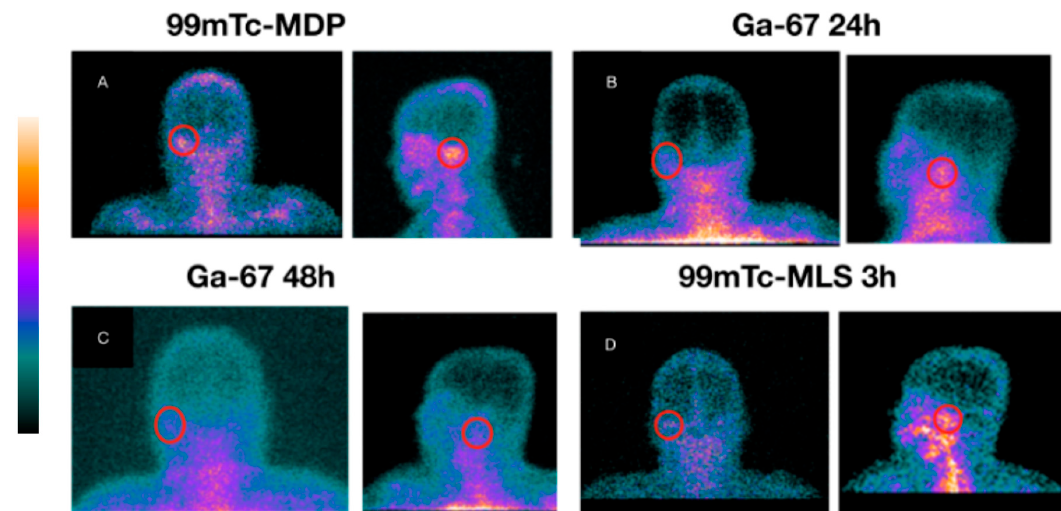
Figure 3. Patient 11. ( A ) Bone 99m Tc-MDP scintigraphy in left mastoid topography (posterior and lateral incidence). ( B ) 67 Ga scintigraphy taken 24 h after radiotracer iv. injection showing higher uptake at the region of interest (ROI, red ring). ( C ) 67 Ga scintigraphy taken 48 h after radiotracer iv. injection showing a long-lasting higher uptake at the ROI. ( D ) 99m Tc-MLS with a higher uptake 3 h after iv. injection of labeled cells. A skin biopsy showed a chronic nonspecific inflammatory process characterized by granulation tissue with recently formed blood capillaries, fibroblasts, and infiltrated leukocytes at the site.